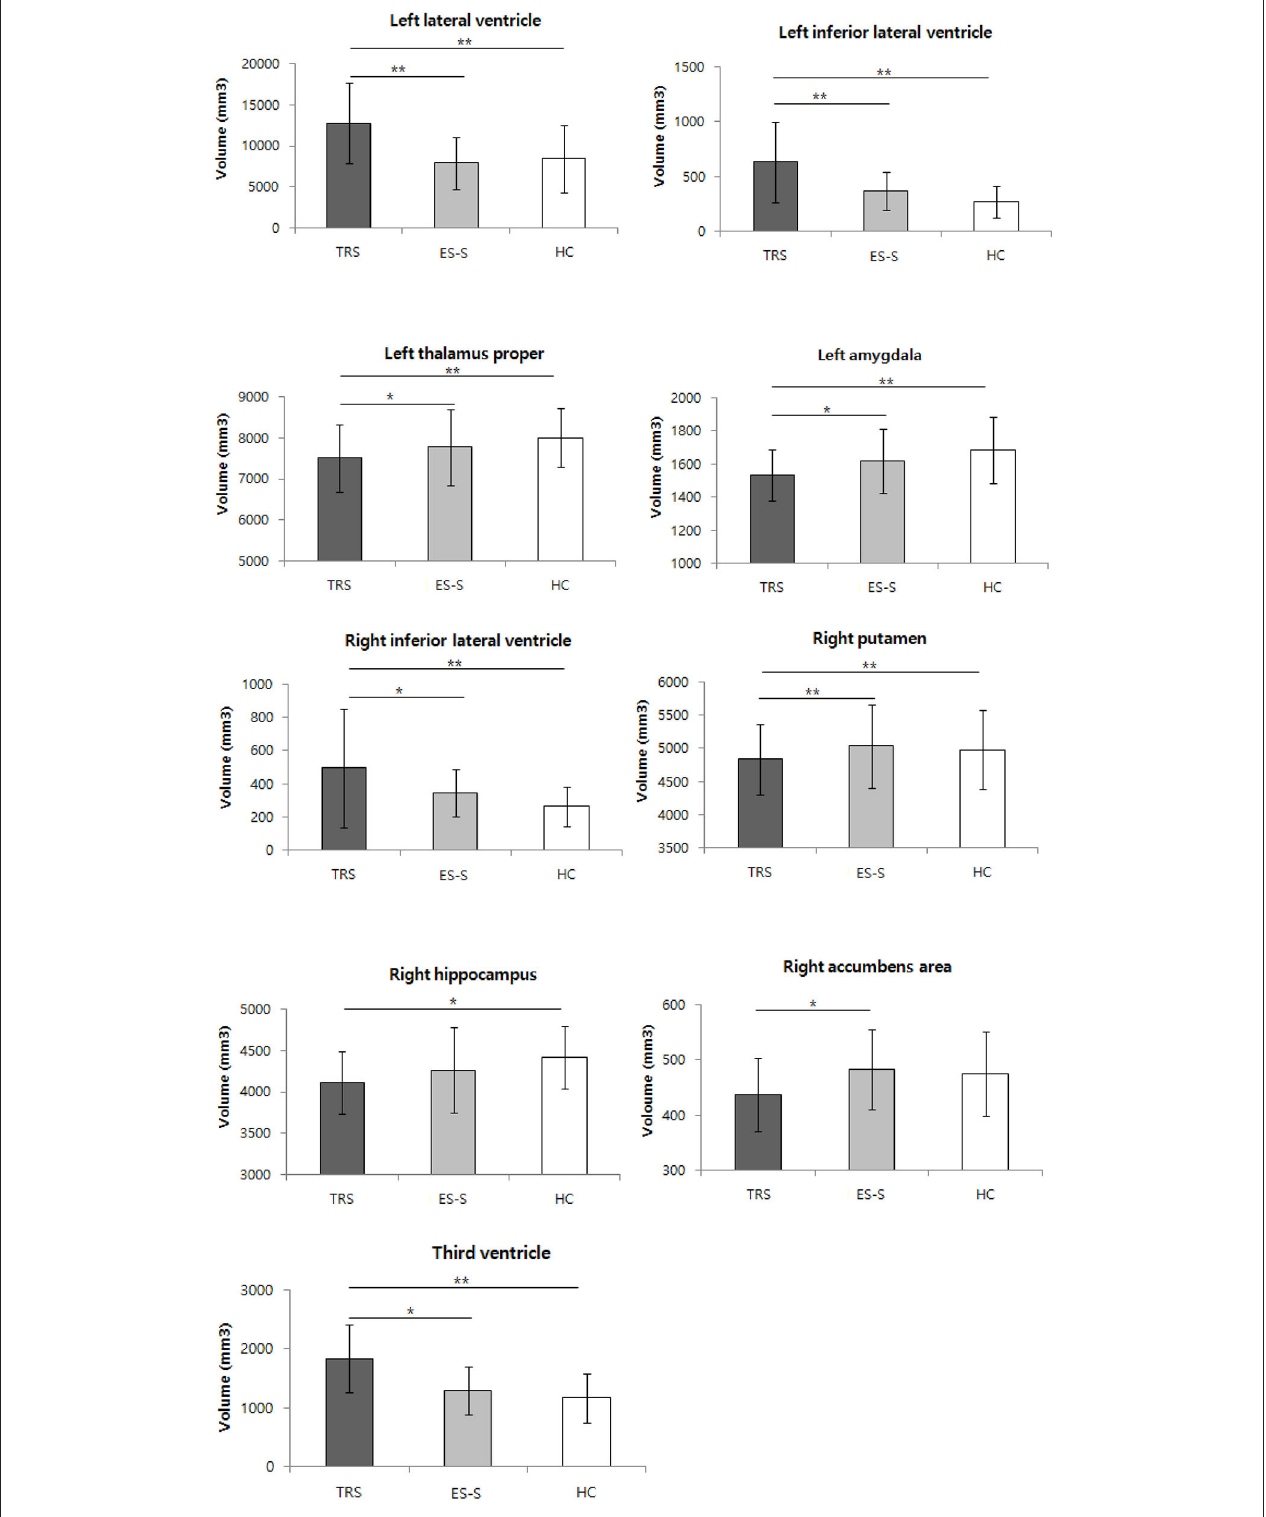
FIGURE 1 | Comparison of subcortical volume among patients with treatment-resistant schizophrenia (TRS) and early-stage schizophrenia (ES-S), and healthy controls (HC). * p < 0.05; ** p < 0.01 in post-hoc test.